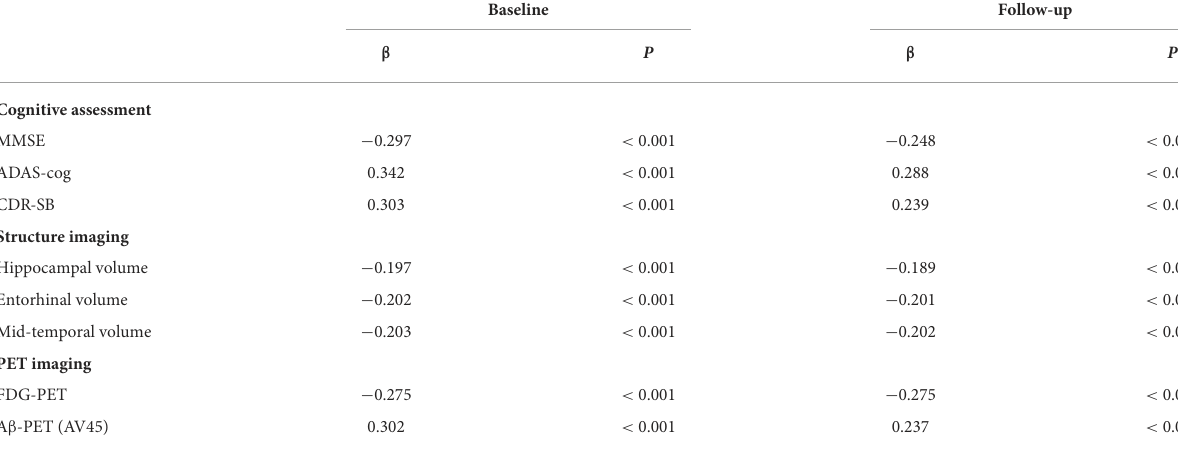
TABLE 2 Correlations of cerebrospinal fluid (CSF) 14-3-3 ζ with cognitive scores and imaging markers.